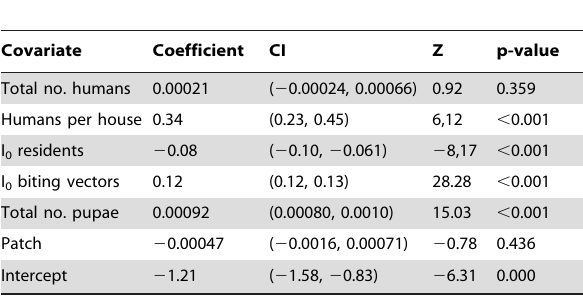
Table 2. Multivariate negative binomial model of secondary human infections (n= 33,600 viral introductions). Table 3. Univariate association of survey indices with